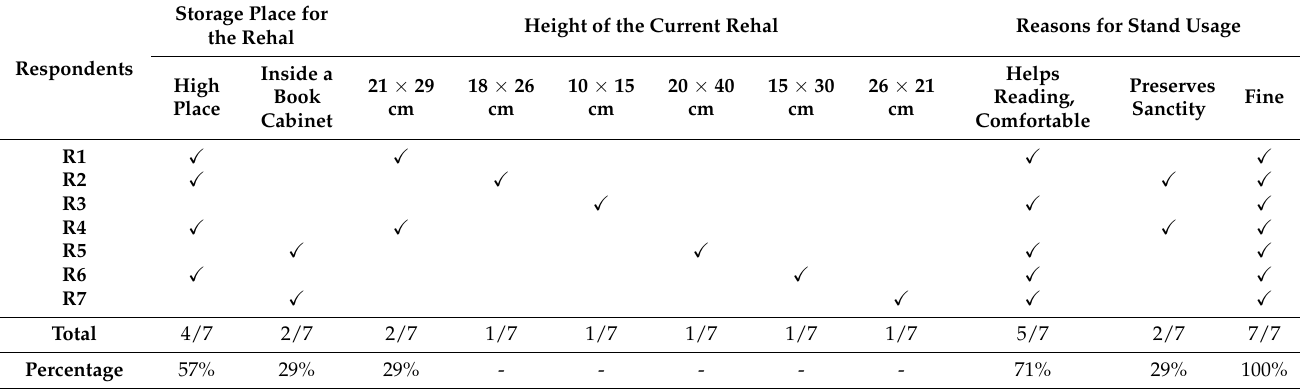
Table 3. Analysis of interview content of Question